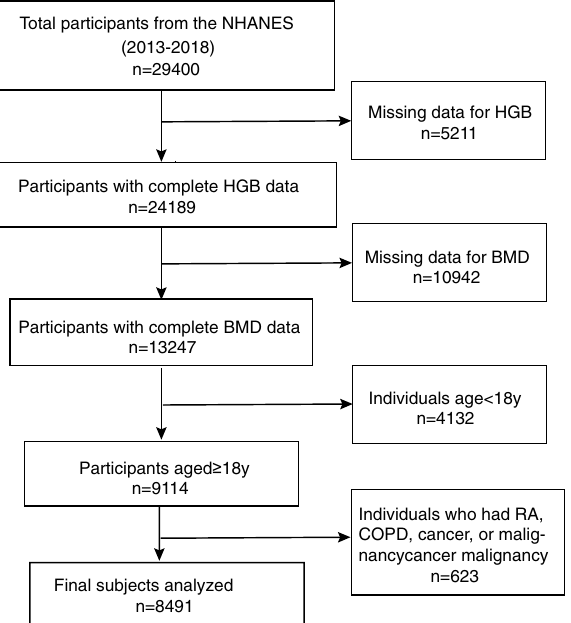
Figure 1. Flow chart of participants